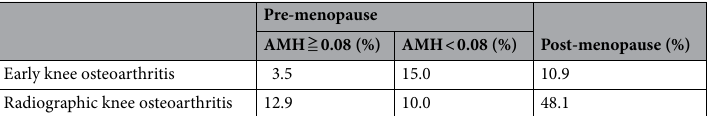
Table 3. Prevalence of knee osteoarthritis in menopausal transition and post-menopausal stage. Prevalence of early and radiographic knee osteoarthritis in menopausal transition and post-menopausal stage. In pre- menopausal stage, subjects were divided into two groups according to the cut-off value (0.08